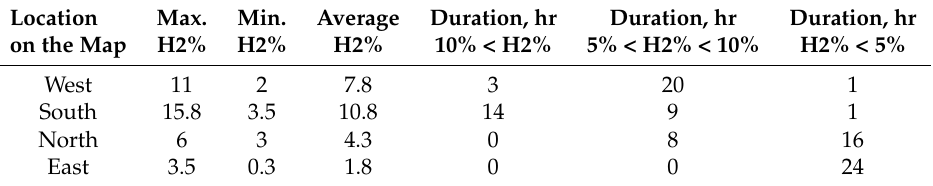
Figure 7 identifies the maximum hydrogen fraction at the nodes in the Irish gas